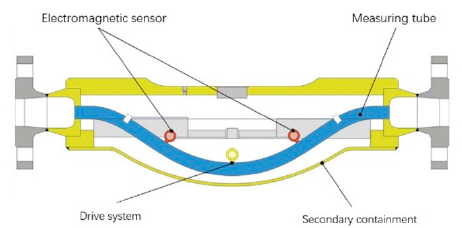
Figure 1. The structure diagram of a micro-bend Coriolis flowmeter.